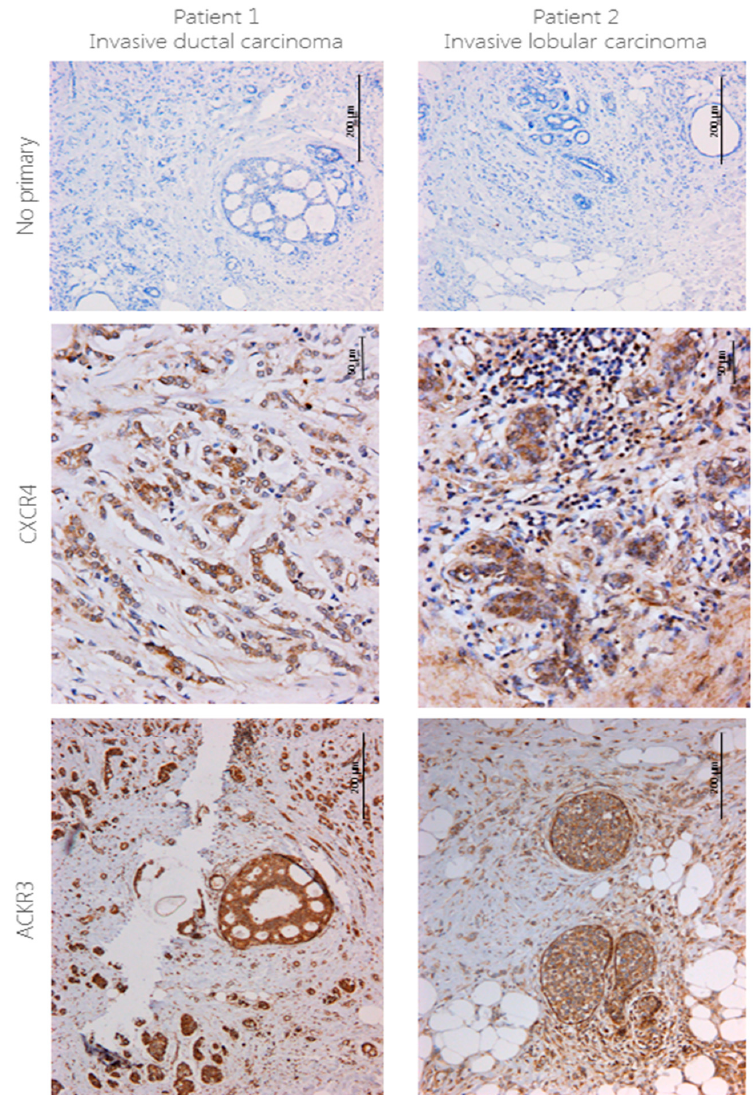
Figure 1. CXCR4 and ACKR3 staining using IHC in breast cancer tissue. 4 μ m sections from human breast cancer were stained for CXCR4 (1:40) and ACKR3 (1:100) using